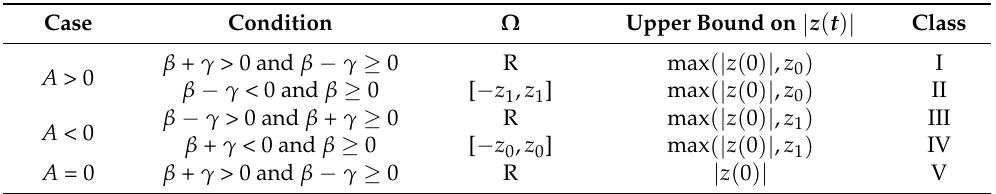
Table 2. Classification of BIBO stable Bouc–Wen model.